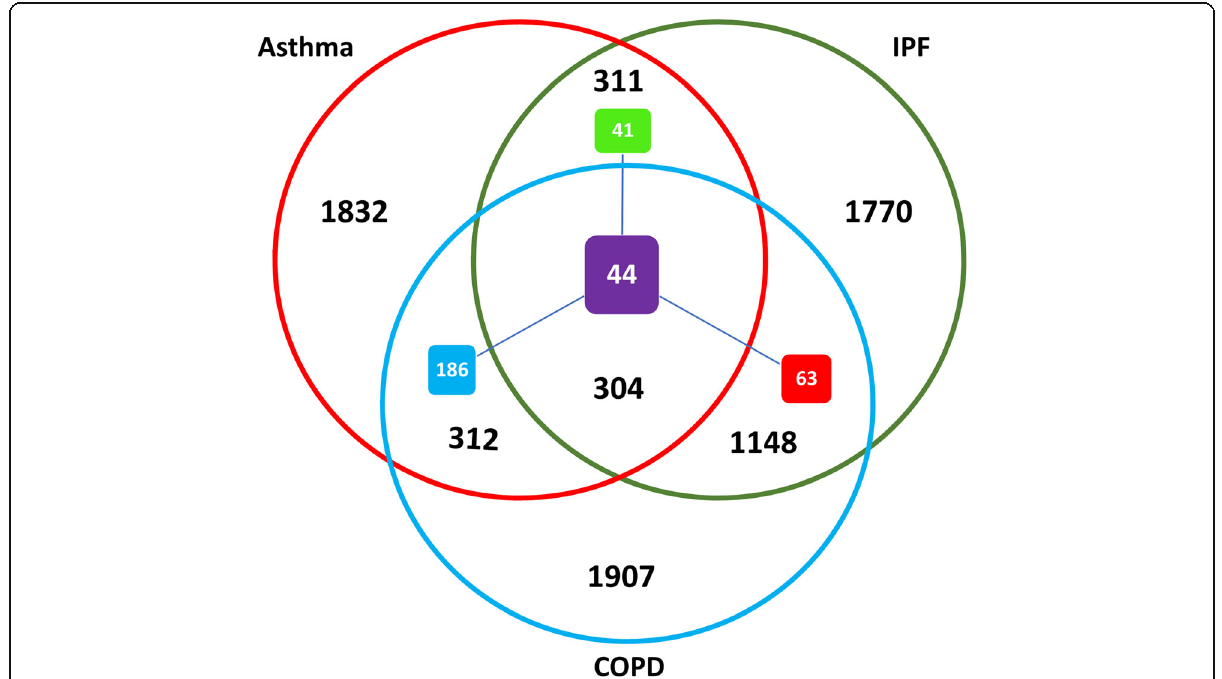
Fig. 2 Venn diagram illustrating the specific and shared DEGs and DIPs among three diseases. The red, blue, and green circles represent asthma, COPD, and IPF DEGs, respectively. The violet and blue, as well as the violet and green squares demonstrate the asthma-COPD and asthma-IPF DIPs, respectively. Finally, the violet and red squares represent COPD-IPF DIPs and the violet square indicates the DIPs among three